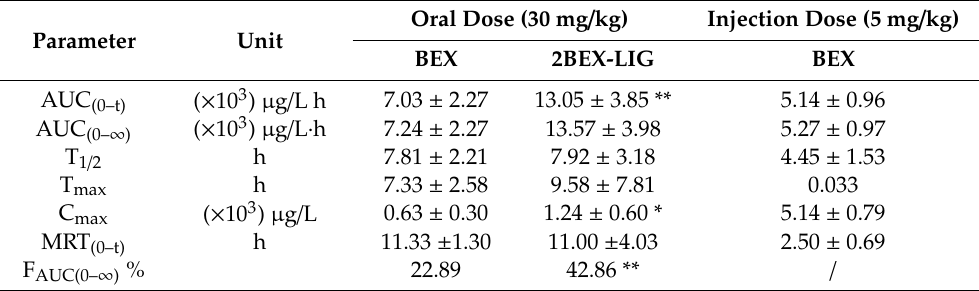
Table 4. Pharmacokinetic parameters of bexarotene (BEX) in Sprague–Dawley (SD) rats. Parameter Unit